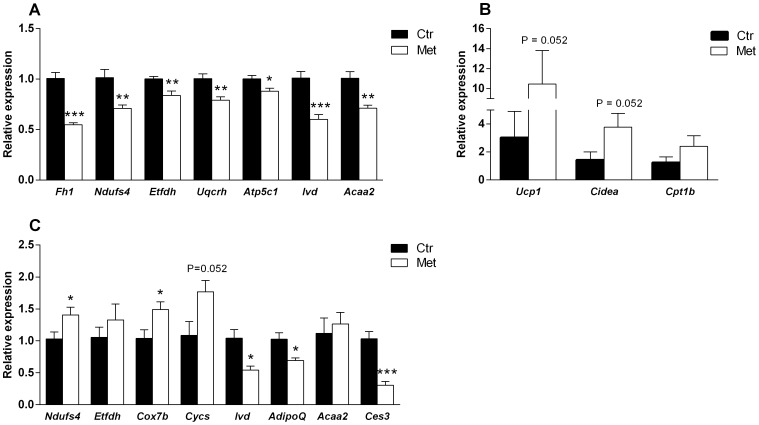
qPCR validation on the microarray-based gene expression profile in the neonatal liver and SAT.The expression of Fh1 (fumarate hydratase 1), Ndufs4 (NADH dehydrogenase (ubiquinone) Fe-S protein 4), Etfdh (electron transferring flavoprotein, dehydrogenase), Uqcrh (ubiquinol-cytochrome c reductase hinge protein), Atp5c1 (ATP synthase, H+transporting, mitochondrial F1 complex, gamma polypeptide 1), Ivd (isovaleryl coenzyme A dehydrogenase) and Acaa2 (acetyl-Coenzyme A acyltransferase 2 (mitochondrial 3-oxoacyl-Coenzyme A thiolase)) in the neonatal liver (A) by qPCR. n = 6 in both groups. * = P<0.05, ** = P<0.01 and *** = P<0.001. The expression of Ucp1 (uncoupling protein 1), Cidea (cell death-inducing DNA fragmentation factor, alpha subunit-like effector A), Cpt1b (carnitine palmitoyltransferase 1b) (B), Ndufs4 (NADH dehydrogenase (ubiquinone) Fe-S protein 4), Etfdh (electron transferring flavoprotein, dehydrogenase), Cox7b (cytochrome c oxidase subunit VIIb), Cycs (cytochrome c), Ivd (isovaleryl coenzyme A dehydrogenase), AdipoQ (adiponectin), Acaa2 (acetyl-Coenzyme A acyltransferase 2 (mitochondrial 3-oxoacyl-Coenzyme A thiolase)) and Ces3 (carboxylesterase 1D) in the neonatal SAT (C) by qPCR. n = 5 in Met and 6 in Ctr group. * = P<0.05 and *** = P<0.001 by Student's t-test or Mann-Whitney test. Ucp1, Cidea and Cpt1b presented separately due to a different scale in the expression levels.